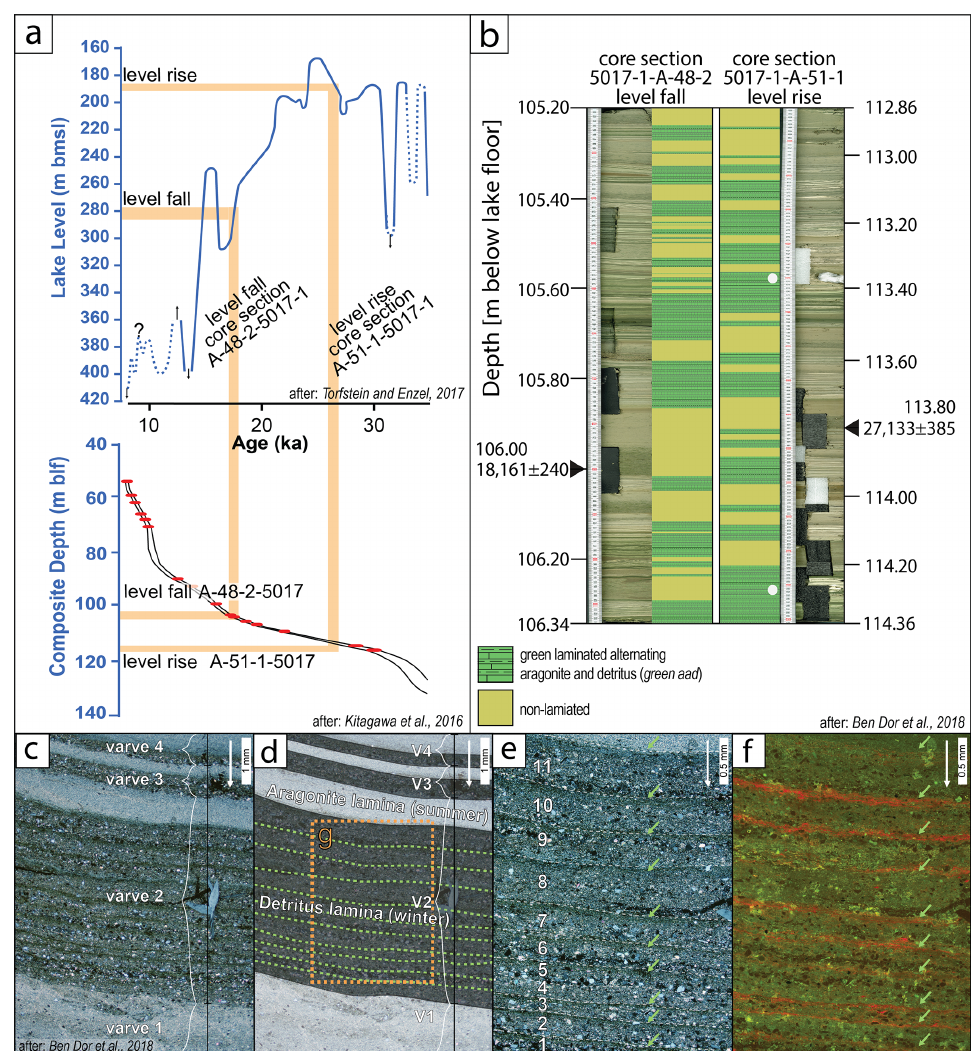
Figure 2. (a) Top: Dead Sea lake level depicting the highest stage of Lake Lisan, the Late Pleistocene predecessor of the Dead Sea, during Last Glacial Maximum (Bartov et al., 2003; Torfstein and Enzel, 2017). Bottom: the age–depth model of the ICDP–DSDDP 5017-1 core and the position of the studied segments along the core (after Kitagawa et al., 2017). (b) The studied sections of the ICDP–DSDDP cores dated to 18 and 27ka (marine isotope stage (MIS) 2, ∼ 15–30ka). (c–f) Microscope images of alternating aragonite (summer precipitate) and detritus (deposited during winter) varves depicting a detrital lamina composed of multiple sub-laminae (labelled 1–11) deposited by individual floods (after Ben Dor et al.,